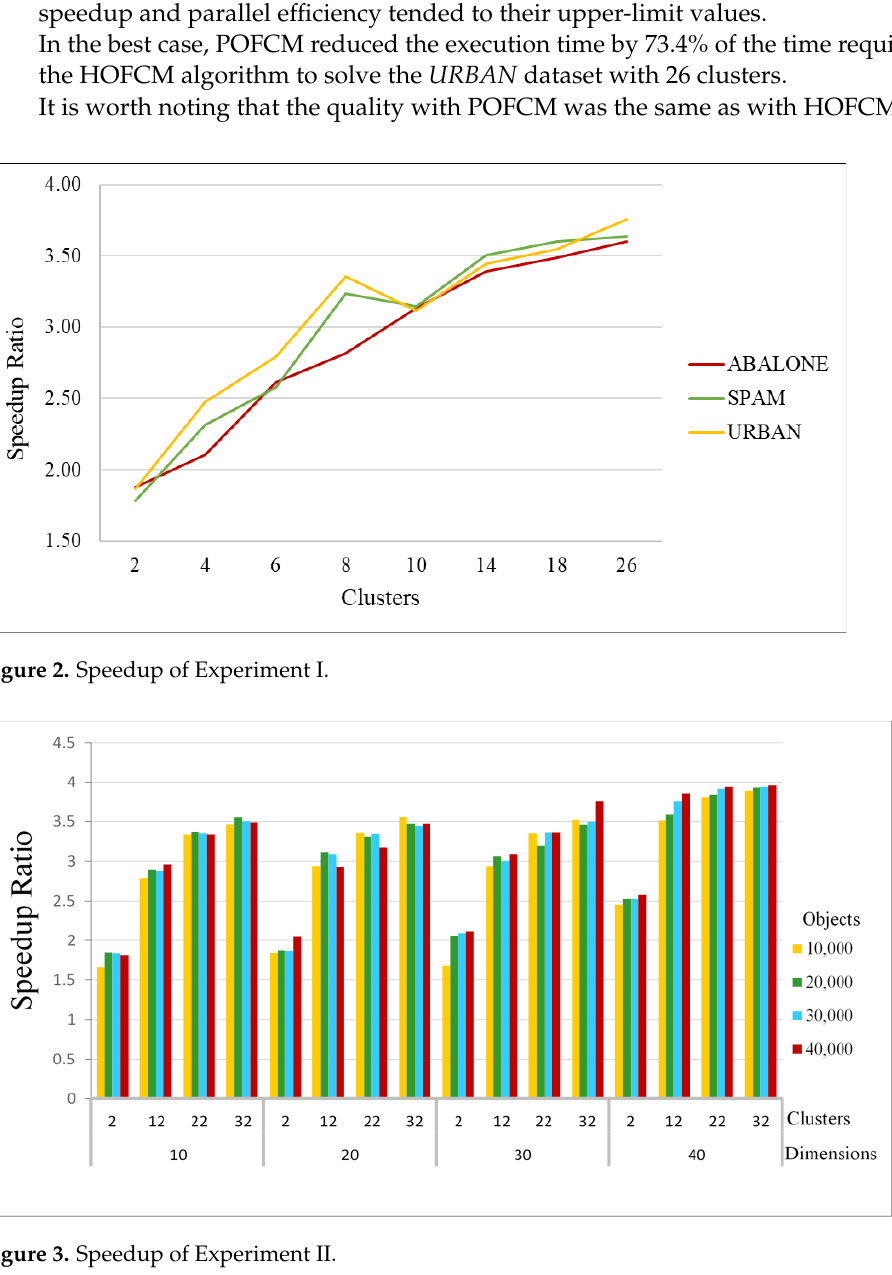
Figure 3. Speedup of Experiment II.